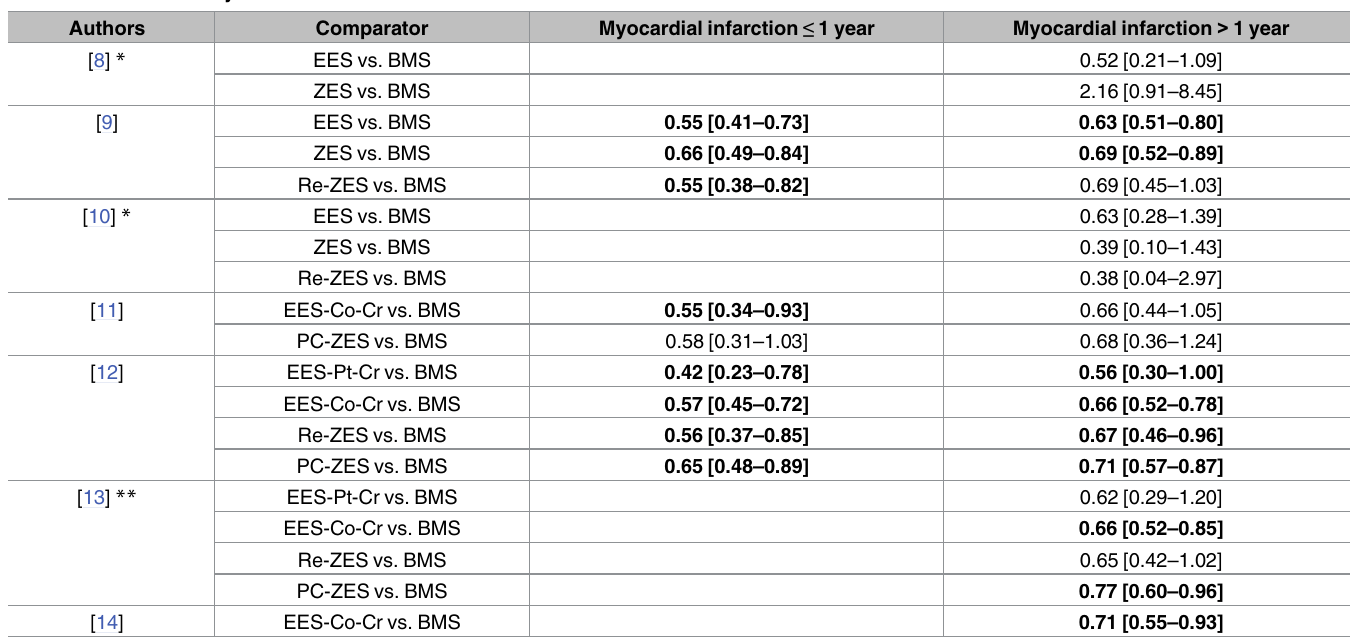
Table 4. Rate ratio of myocardial